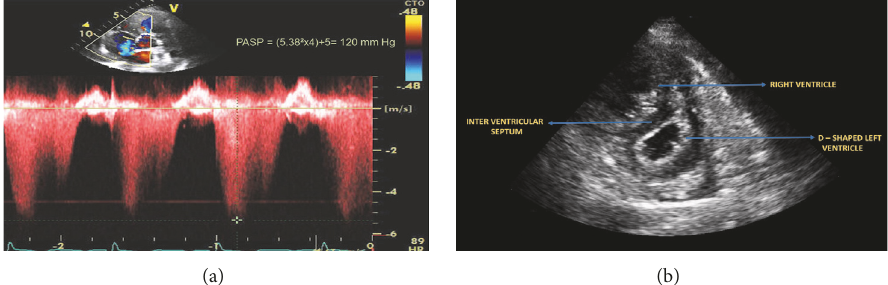
Figure 1: (a) Tricuspid regurgitation signal on echocardiogram at 25 weeks of gestation showing peak velocity of 5.38 m/s and Pulmonary Artery Systolic Pressure (PASP) of 120mmHg. (b) Echocardiogram at 25 weeks of gestation showing enlarged right ventricle and D-shaped left ventricle.